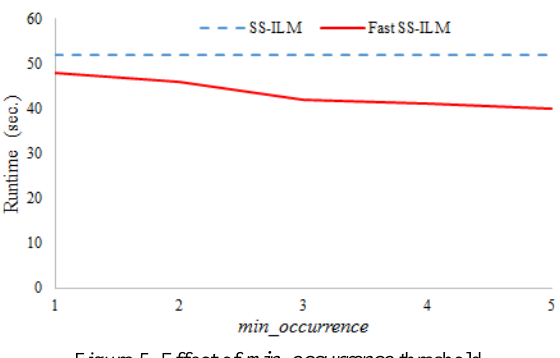
Figure 5. Effect of min_occurrence threshold